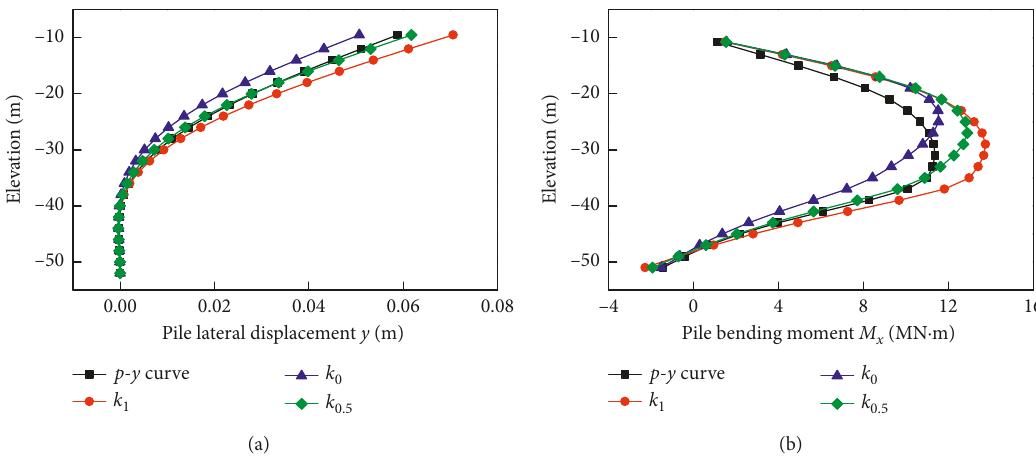
Figure 18: 1 st row pile responses by the structure with different SPI models. (a) Pile lateral displacement y in the 5 th row. (b) Pile bending moment M x in the 5 th